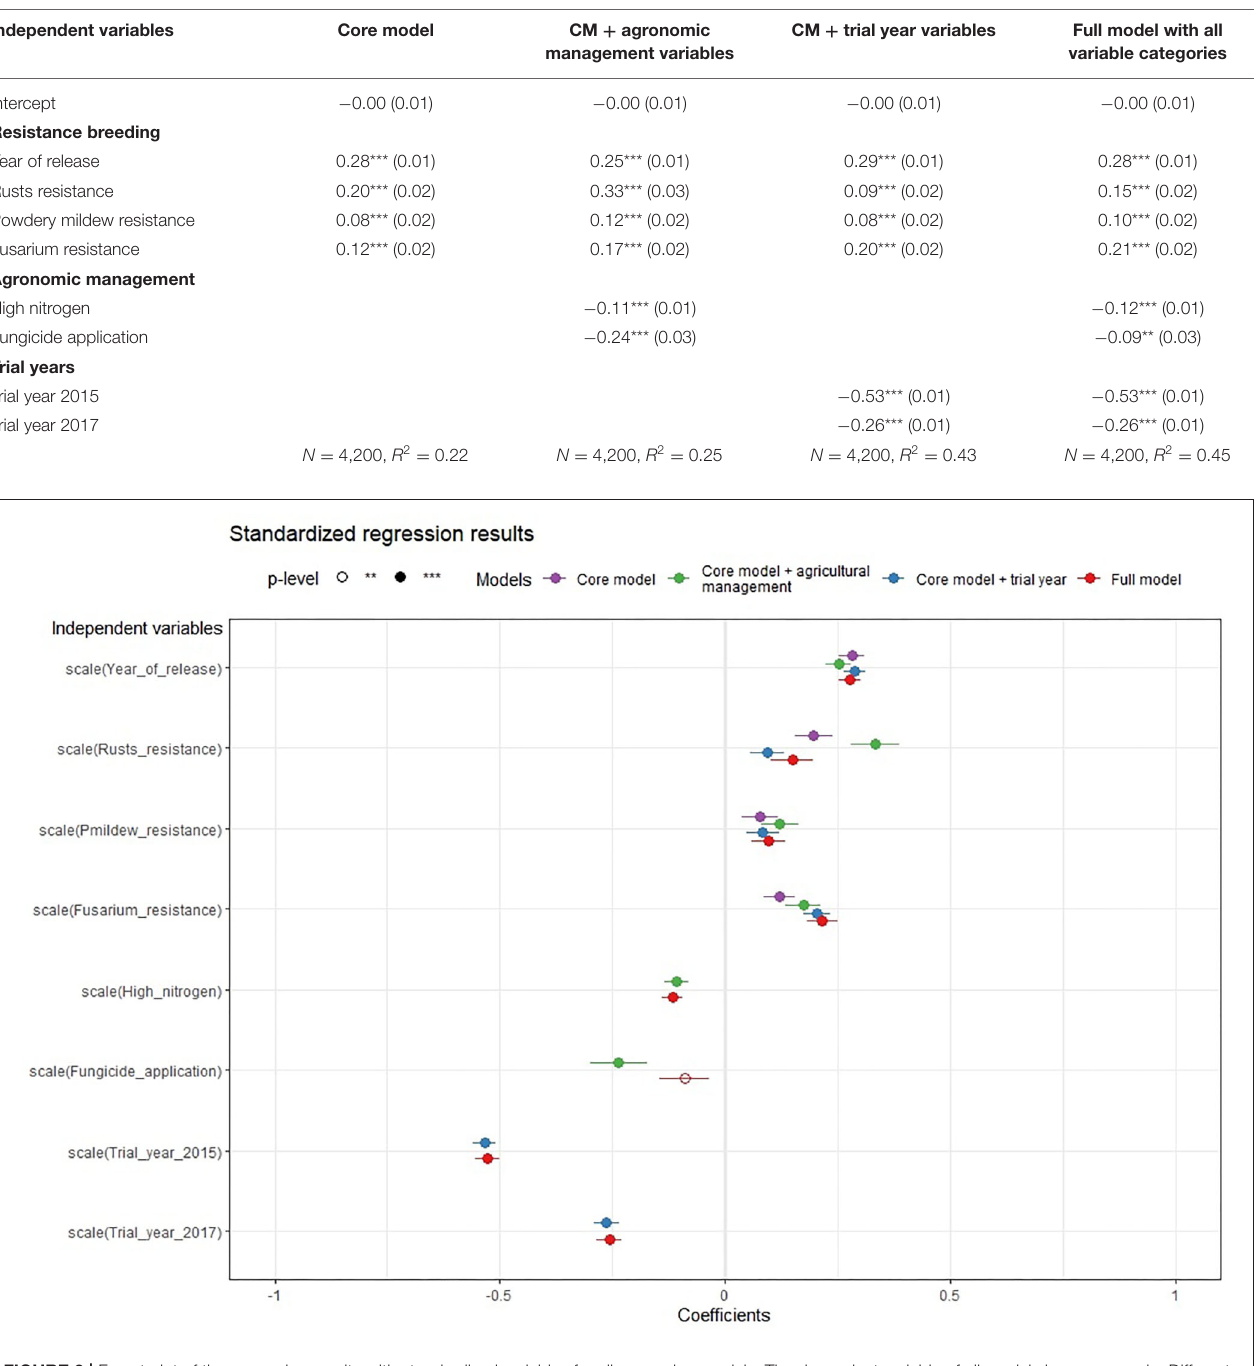
FIGURE 2 | Forest plot of the regression results with standardized variables for all regression models. The dependent variable of all models is gross margin. Different models are identified by different colors. The plot shows the magnitude (indicated by the circle position) and uncertainty (tails around the circles show the 0.95 confidence interval) of coefficients of the variables in all regression models. A filled circle indicates statistical significance at the level of p < 0.001 and a not filled circle at the level of p < 0.01. As variables were standardized, the coefficient magnitude of differently scaled variables can be better compared. When a circle is positioned to the right of the vertical zero lines, it means that the variable increases the gross margin of the dependent variable. For every additional unit of a variable (e.g., one additional percentage point of healthy leaf area), the gross margin increases by the coefficient of the variable, and when a point is located to the left of the zero lines, the variable is estimated to have a negative influence on the dependent variable so that it decreases the gross